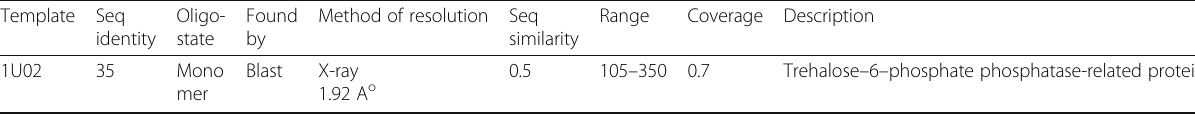
Table 3 Template TPP from PDB with specifications Template Seq Oligo- Found identity state